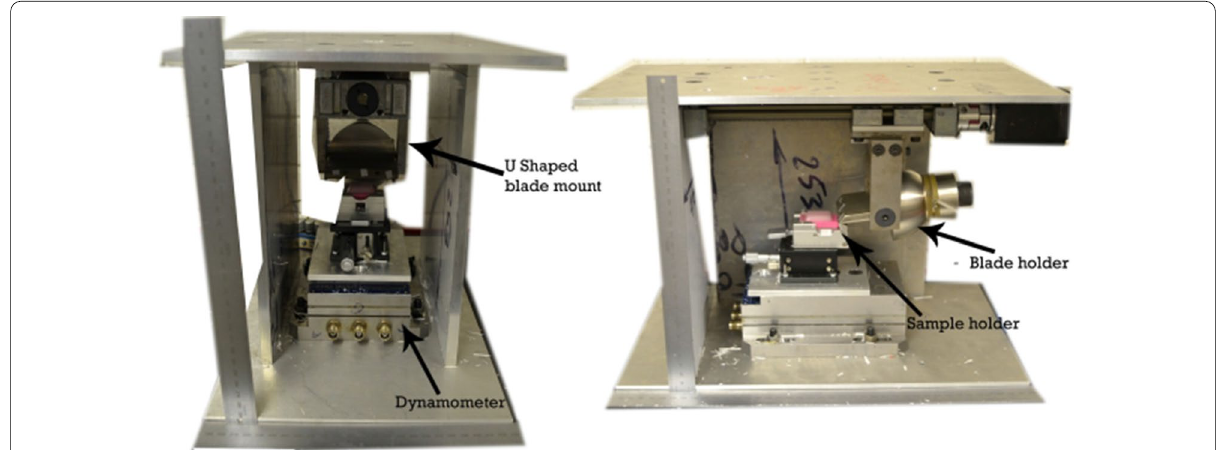
Figure 2 Image of test rig used to measure cutting forces for both conventional and ultrasonically assisted